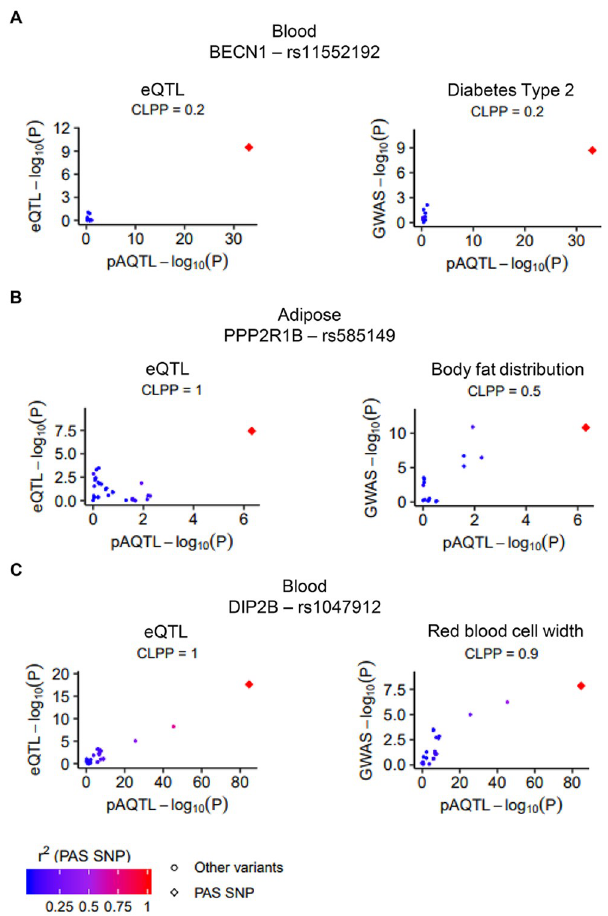
Fig 6. Colocalization of pA-QTL, eQTL and GWAS signals. Examples of PAS pA-QTLs that showed marked colocalization with both eQTL and GWAS signals in the 3’UTRs of the genes: A . BECN1 . B . PPP2R1B . C . DIP2B . Dots are colored according to their LD (r 2 ) with the PAS SNP (calculated according to GTEx VCF files for eQTL plots and according to genome 1000 VCFs files for GWAS plots). Diamond shape signifies the PAS SNP. CLPP is colocalization posterior probability calculated using eCaviar